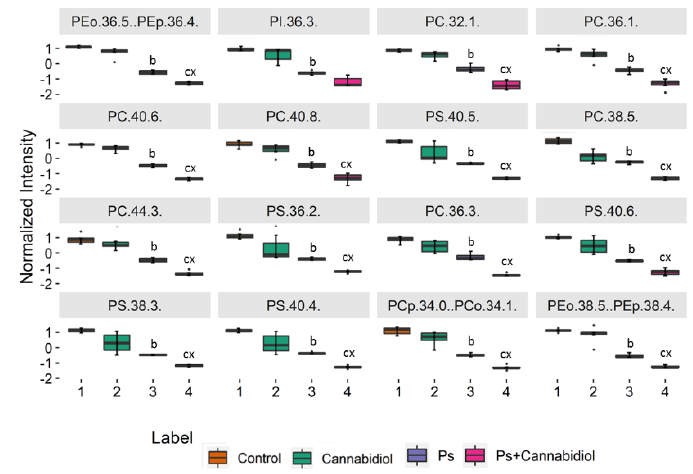
Figure 2. Boxplots of the 16 most discriminating PL molecular species (according to Kruskal–Wallis and the post hoc Dunn multiple comparison tests) identified in keratinocytes isolated from the skin of healthy subjects (Control) and psoriatic patients (Ps). These cells were either not treated or treated with Cannabidiol (CBD) (4 μM). The following groups of keratinocytes were studied: Control, CBD, Ps, and Ps + CBD. p < 0.05 was considered statistically significant: b, control vs. Ps; c − control vs. Ps + CBD; x − Ps vs. Ps + CBD.